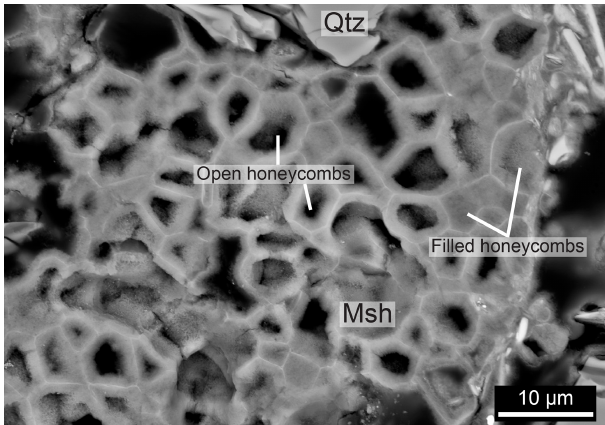
Figure 5. BSE images of honeycomb texture with typical 2–10µm diameter pore spaces. The texture consists of magnesium silicate hydrate cement (Msh), and the interior is either empty (black) or filled with cement (grey) with a different contrast, signifying a dif- ferent density. The size of the individual honeycomb cells does not seem to correlate with the cell being filled or not. No quartz (Qtz) is present, except at the top of the